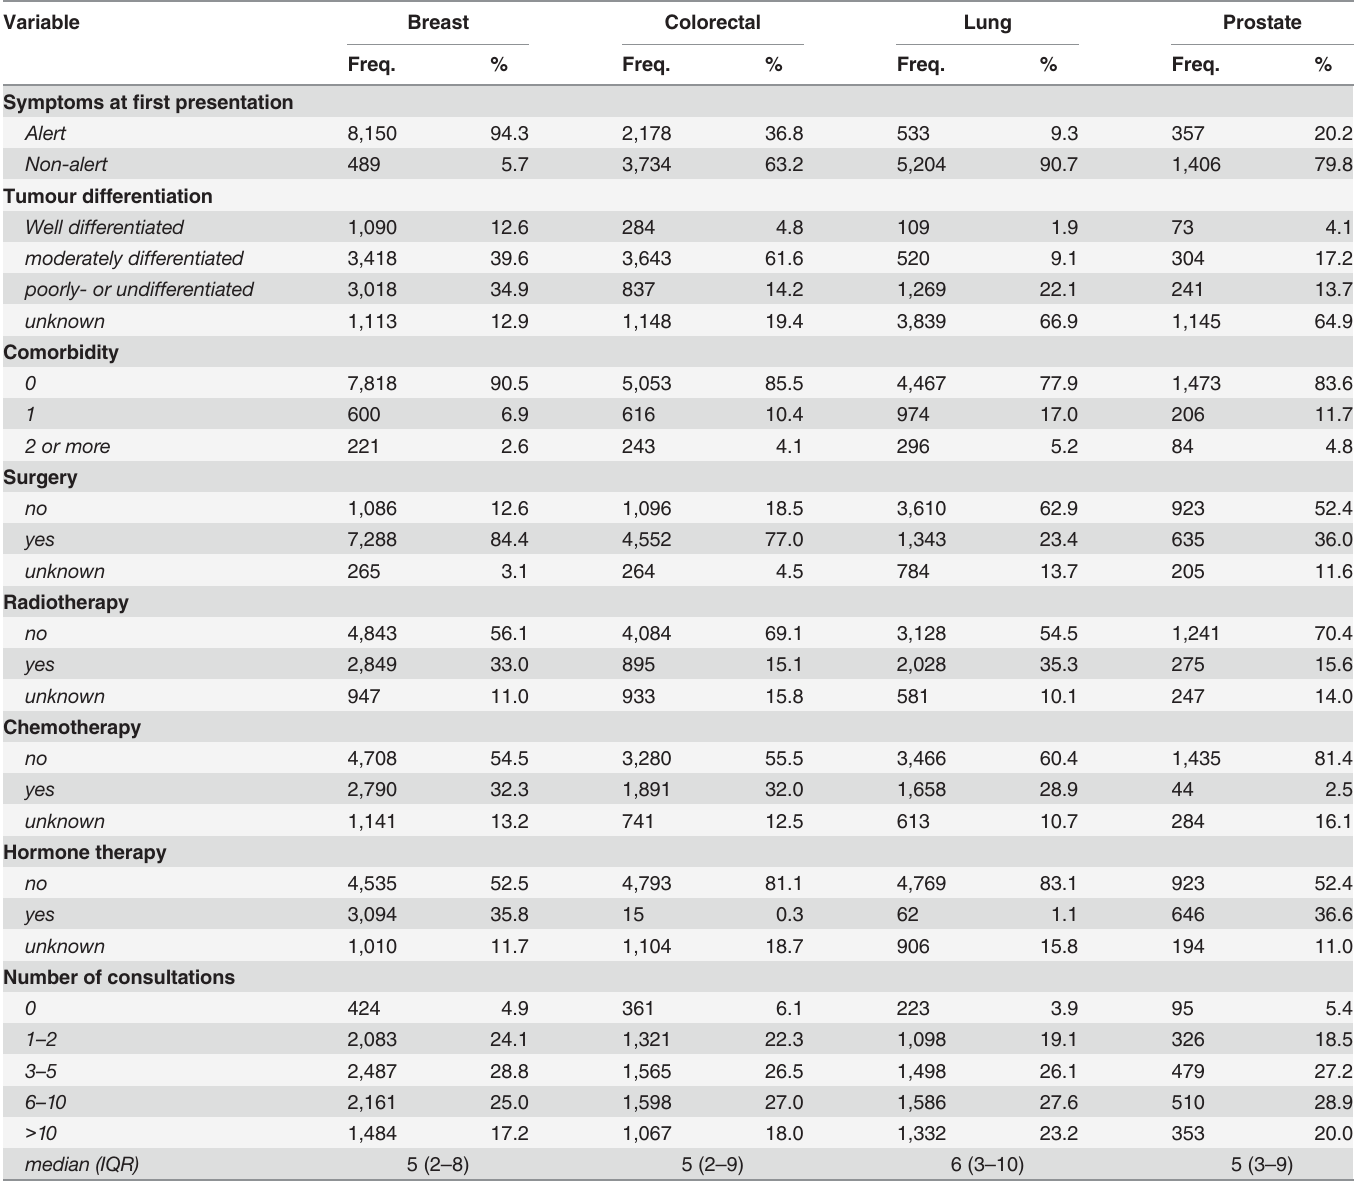
Table 2. Tumour and clinical characteristics of patients by cancer site.